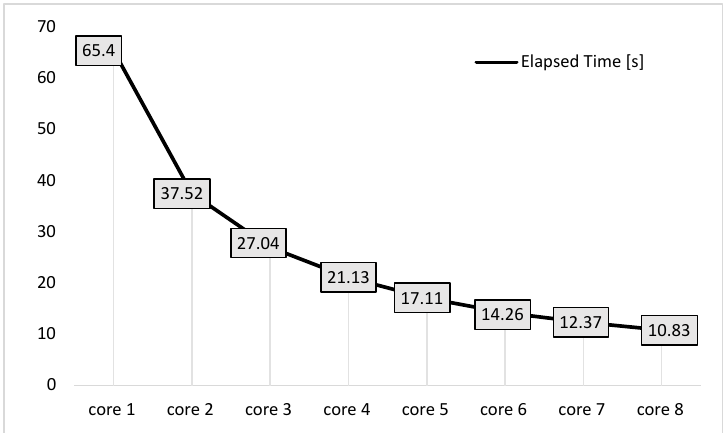
Figure 8. Total computation time for 100k input symbols using a different number of cores.